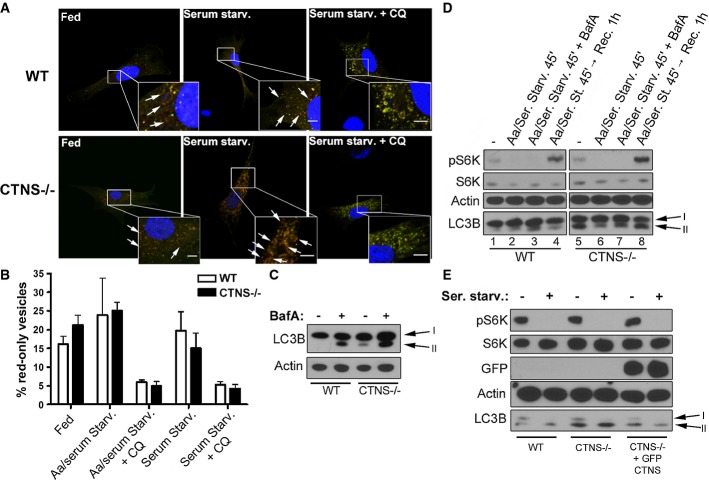
Analysis of the macroautophagic flux in Ctns−/− cells
Representative images of wild-type (WT) and Ctns−/− mouse fibroblasts transfected with the ptfLC3 vector under resting conditions (fed), or after serum starvation (Serum Starv.) in the presence or absence of the alkalinizing drug chloroquine (CQ). GFP and RFP staining was analyzed by confocal microscopy. Examples of red-only puncta (mature autophagosomes) are indicated with arrows. Scale bar: 5 μm.

The percentage of mature autophagosomes (red-only vesicles) was calculated based on the ratio between the number of red-only puncta and the total number of autophagosomes (number of green and red + red-only puncta). The graph is representative of three different experiments with similar results. Results are mean ± SEM (n = 7 cells per condition). In addition to the experimental conditions shown in (A), the Aa/serum starvation condition is included.

WT and Ctns−/− fibroblasts under resting conditions were treated with 100 nM bafilomycin A (BafA) for 2 h and LC3B-II levels were analyzed by Western blot (WB).

Phosphorylation levels of the mTOR complex kinase 1 substrate S6K and LC3B-II levels in WT and Ctns−/− fibroblasts were measured by WB under resting conditions (−), withdrawal of both amino acids and serum (Aa/Ser. Starv.) and subsequent recovery by replacement of starvation medium with normal cell growth medium (Rec), in the presence or absence of 100 nM BafA for the indicated time.

WB analysis showing phosphorylation levels of the mTOR substrate S6K and expression of LC3B-II in resting or serum-starved WT,Ctns−/− and Ctns−/− fibroblasts expressing GFP-CTNS.
Source data are available online for this figure.